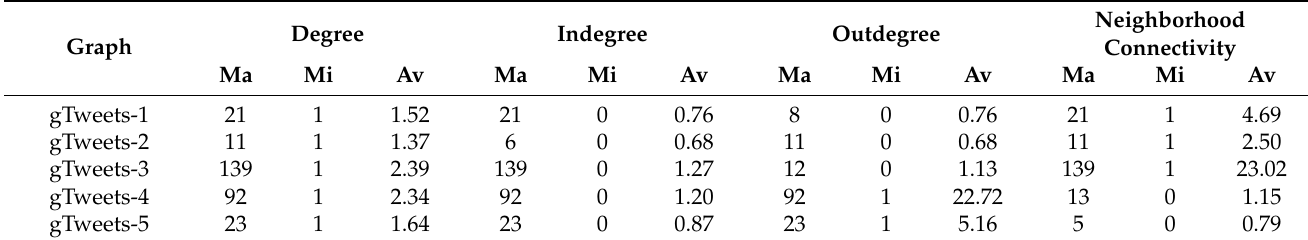
Table 3. Statistics of the graphs.